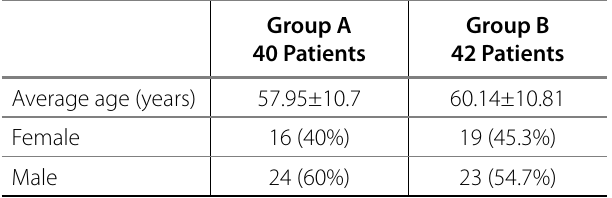
Table 1. Characteristics of Group A and B.